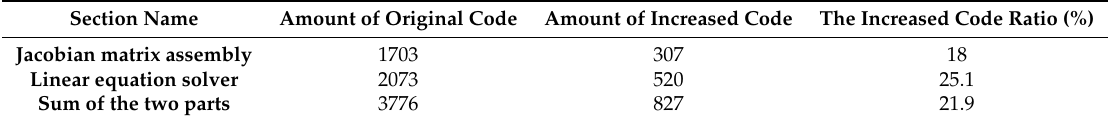
Table 2. Evaluating the workload of porting the